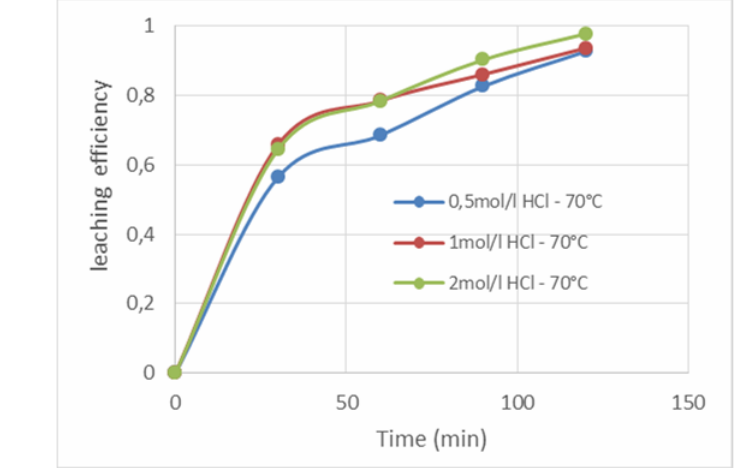
Figure 6 – Influence of the concentration of hydrochloric acid on iron dissolution at 70°C Рис . 6 – Влияние концентрации соляной кислоты на процесс растворения